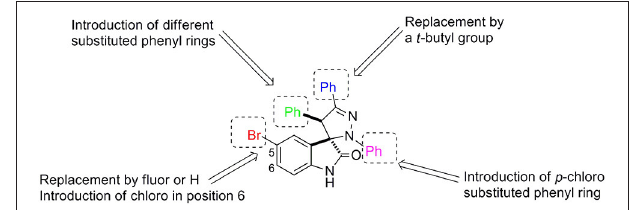
FIGURE 1 | Structural modifications introduced in the spiropyrazoline oxindole scaffold.